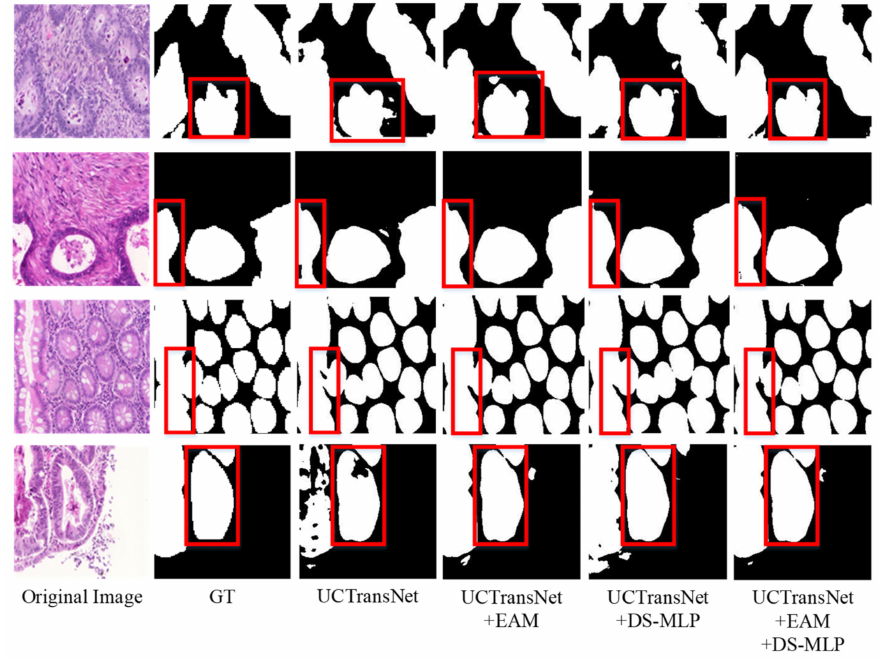
Figure 9. Visual comparison of each module in GlaS dataset. In the red box are the parts with significant differences in the segmentation results of each network.